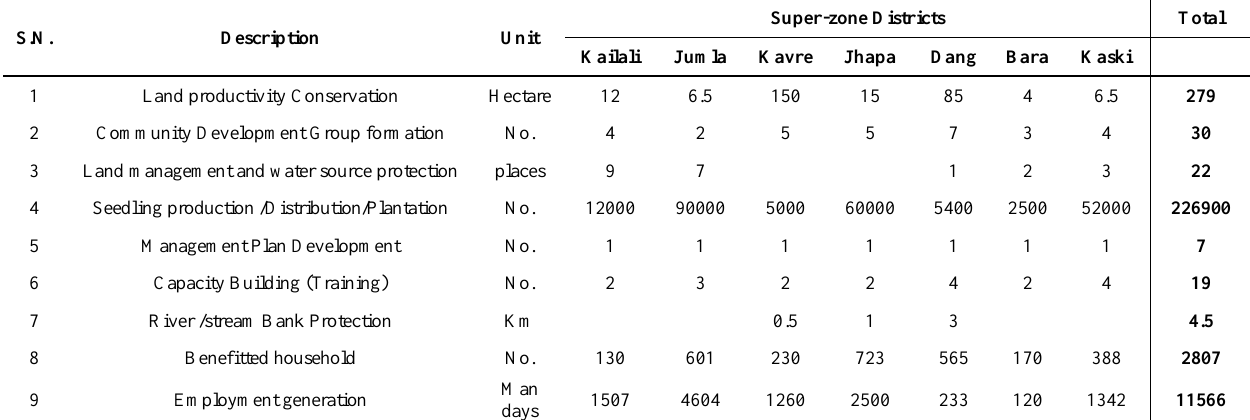
Table 2. Annual progress of seven SDPs under PMA-MP